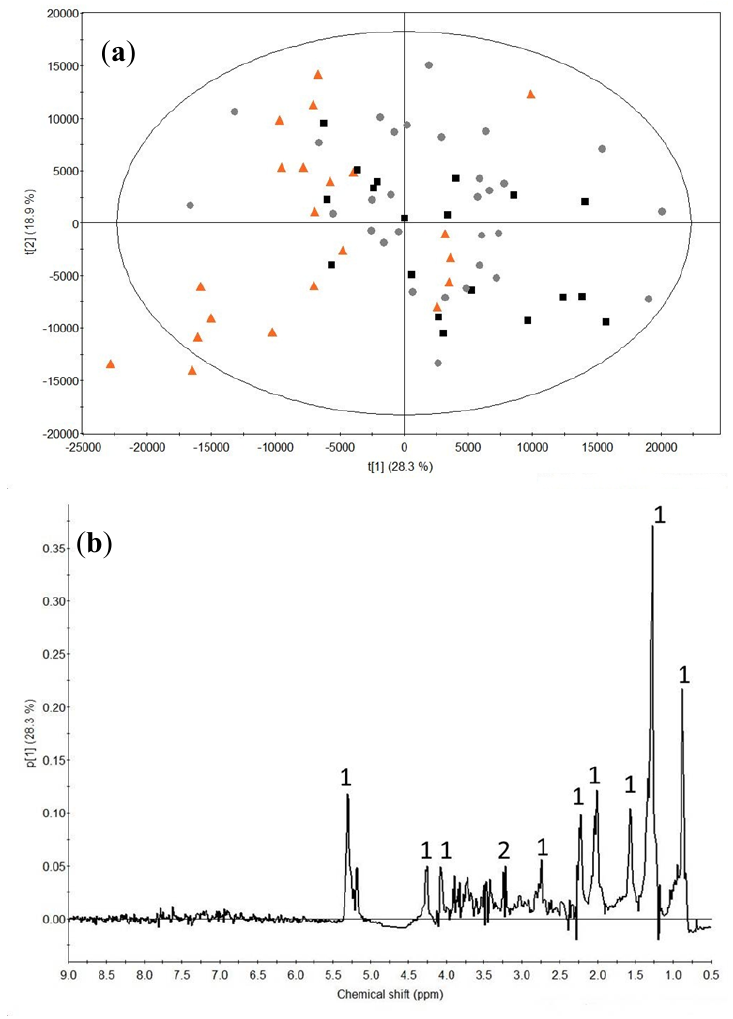
different protein sources: orange-triangle, control; black-box, whey protein; grey-dot, calcium caseinate protein. ( b ) PCA loadings for component 1. Nomenclature: 1, lipid; 2, choline. The ellipse represents the Hotelling T2 with 95%